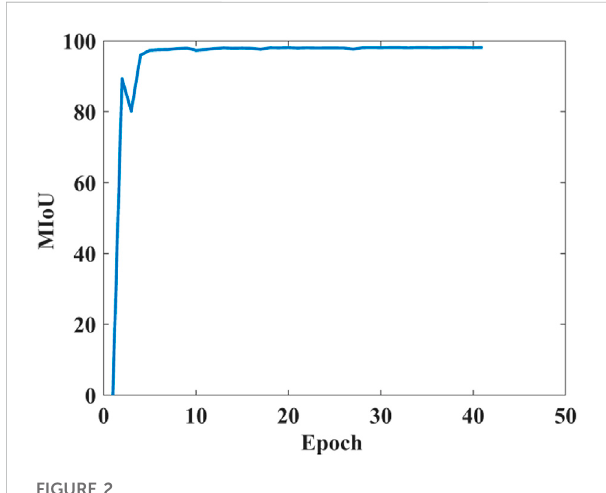
FIGURE 2 Evaluation curve of training MIoU.